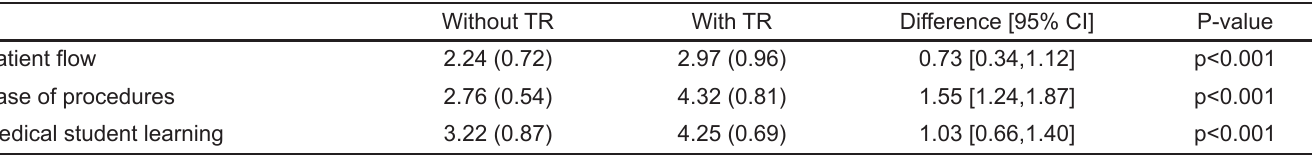
Table 3. Emergency medicine resident evaluation of emergency department experiences with and without the presence of the teaching resident (TR). Five-point scale responses were converted to ordinal numbers where 1=“Poor” and 5=“Excellent”. Values are reported